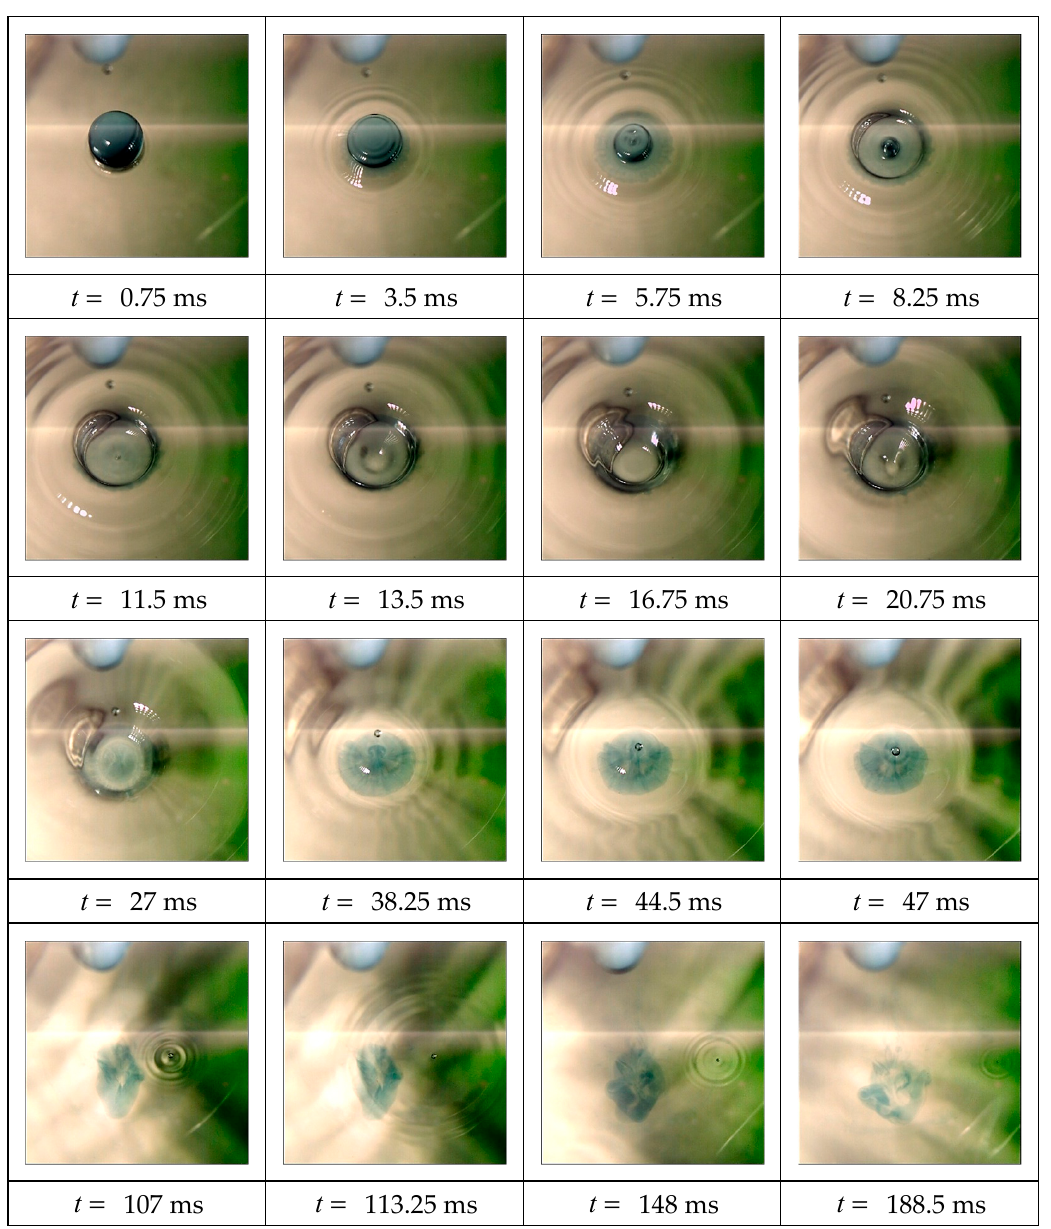
Figure 5. Top view of the flow produced by slow falling drop of an aqueous ink solution diluted at ratio 1:2500 coalescing with tap water ( D = 4.3 mm, U = 0.34 m/c, E σ = 4 µ J, E k = 2.24 µ J, Re = 1460, Fr = 2.8, We = 6.7, Bo = 2.5, Oh = 0.0018, R E = E k / E σ = 0.57, R w = 7.8 × 10 − 7 ). = 6.24 mm and the width of the quiet zone The outer diameter of the dyed area is d s i is ∆ r λ = 1.6 mm (the leading edge advance velocity is u = d ( ∆ r λ ) / dt = 28 cm/s). The = 23.2 cm/s for waves with minimum phase velocity of capillary wave propagation is c min ph = 17.7 cm/s for λ = 4.4 cm. The length λ c = 1.74 cm, the minimum group velocity is c min c g